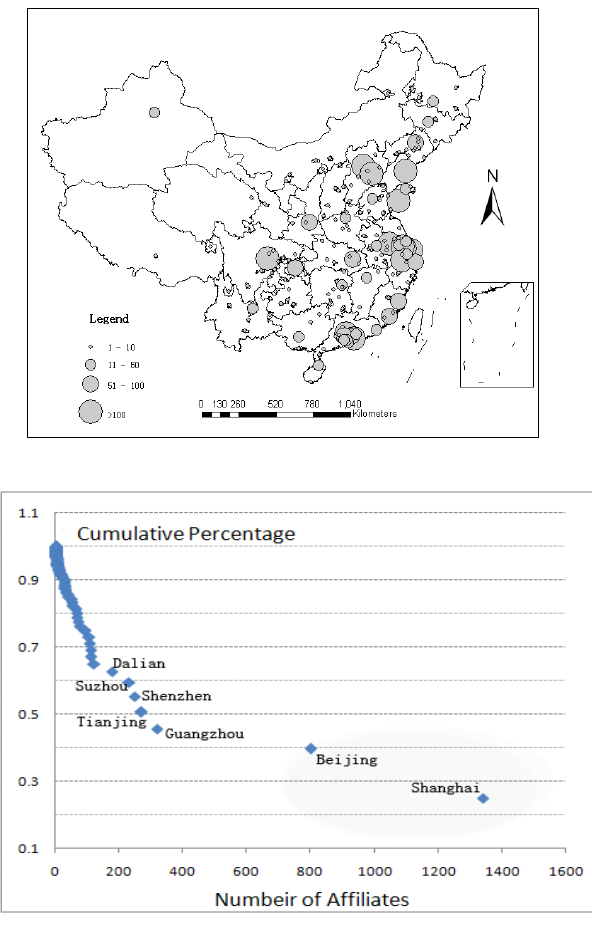
Figure 1: Spatial Distribution of Fortune Global 500 MNCs’ Subsidiaries in China